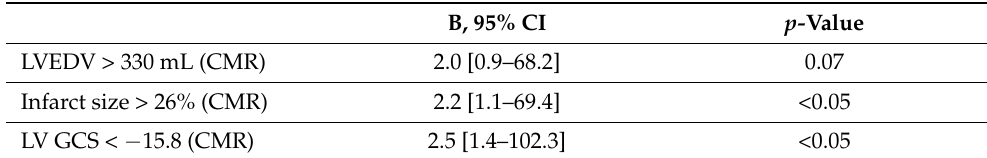
Table 7. Binary logistic regression model for the prediction that the reversibility score is < 10, Nagelkerke R 2 0.57; overall percentage 80.6. B, 95%